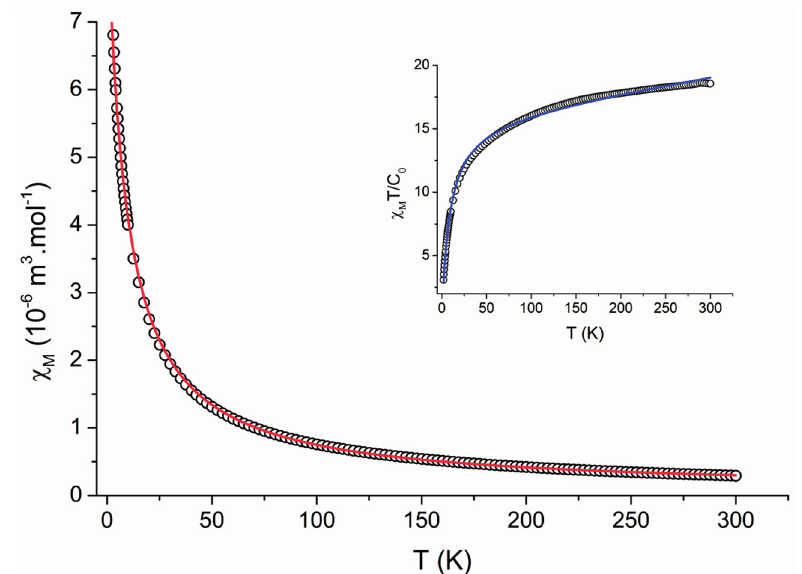
Figure 11. The temperature-dependence of the magnetic susceptibility ( χ M , ○ ) and χ M T/C 0 (inset) for complex 6 . The best fit of χ M is represented by the solid